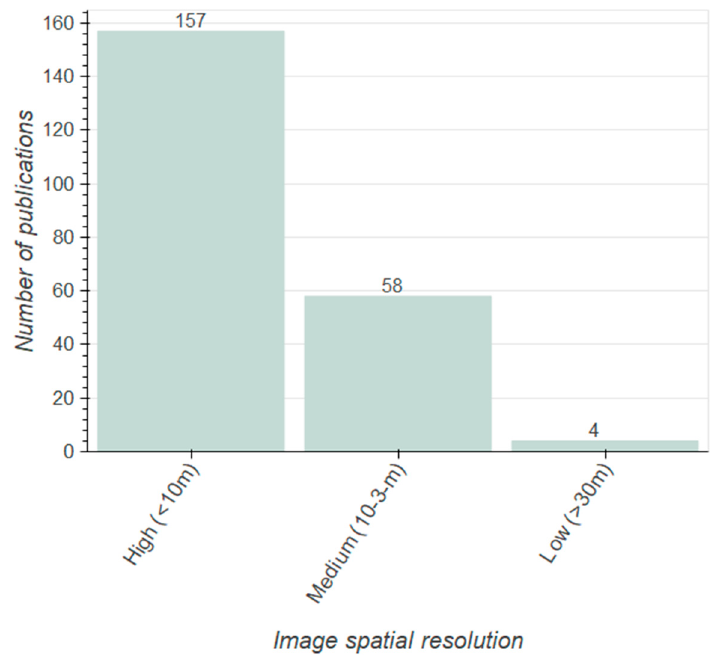
Figure 12. The spatial resolution of the used RS images in the papers.